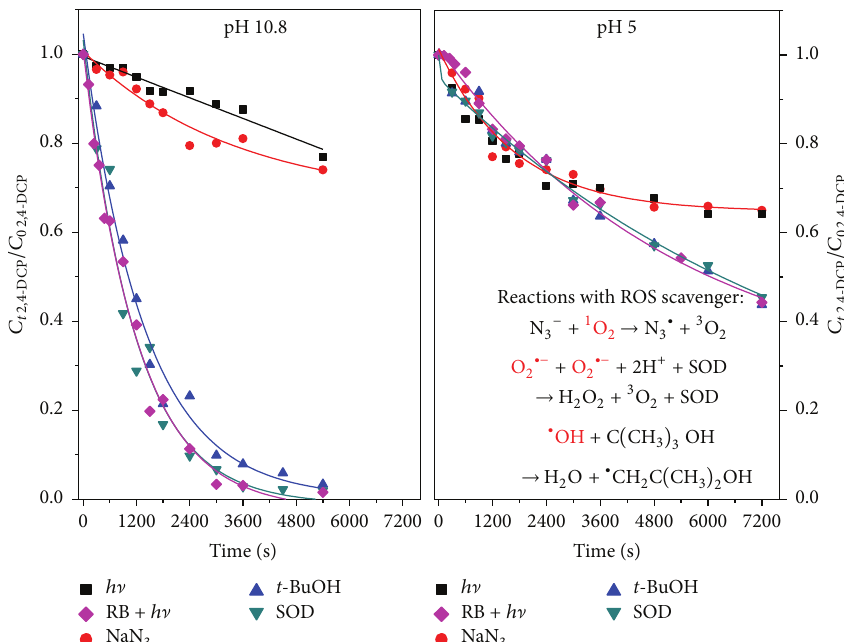
Figure 1: The dependence of 2,4-DCP relative concentrations decay on pH of reaction solution and presence of various ROS scavengers = 2.4 × 10 −4 M, 𝐶 0 RB = 2 × 10 −5 M, 𝐶 0 NaN ( 𝐶 02,4 - DCP lamp